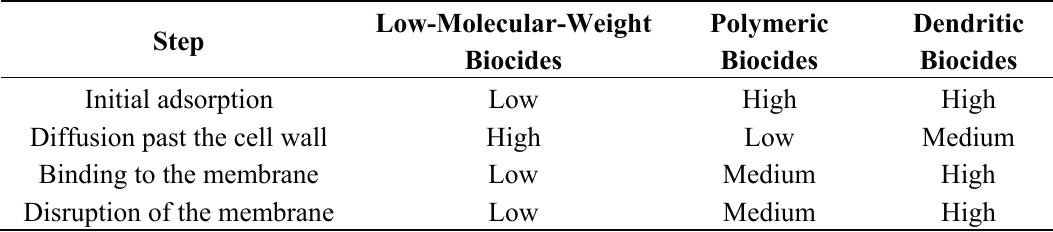
Figure 4. ( a ) QAS modified hyper-branched polyester, adapted from [93]; ( b ) QAS-modified poly(amidoamine) dendrimers with NO-releasing function, adapted with permission from [95]; ( c ) QAS-modified poly(propylene imine) dendrimers, adapted with permission from [97]. Table 1. Comparison of molecular biocides in their interaction with